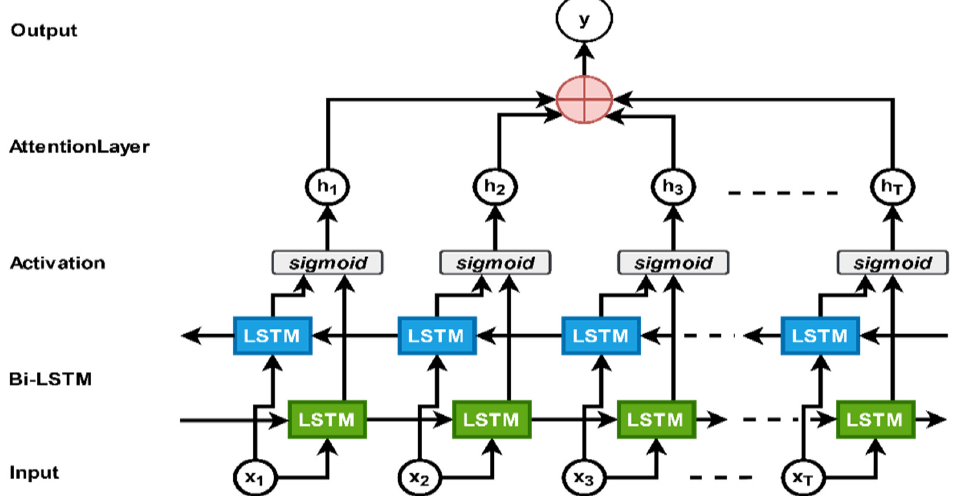
Figure 3. Bi ‐ LSTM with an attention mechanism. For our proposed model, we used the attention mechanism with bi ‐ LSTM as an encoder.